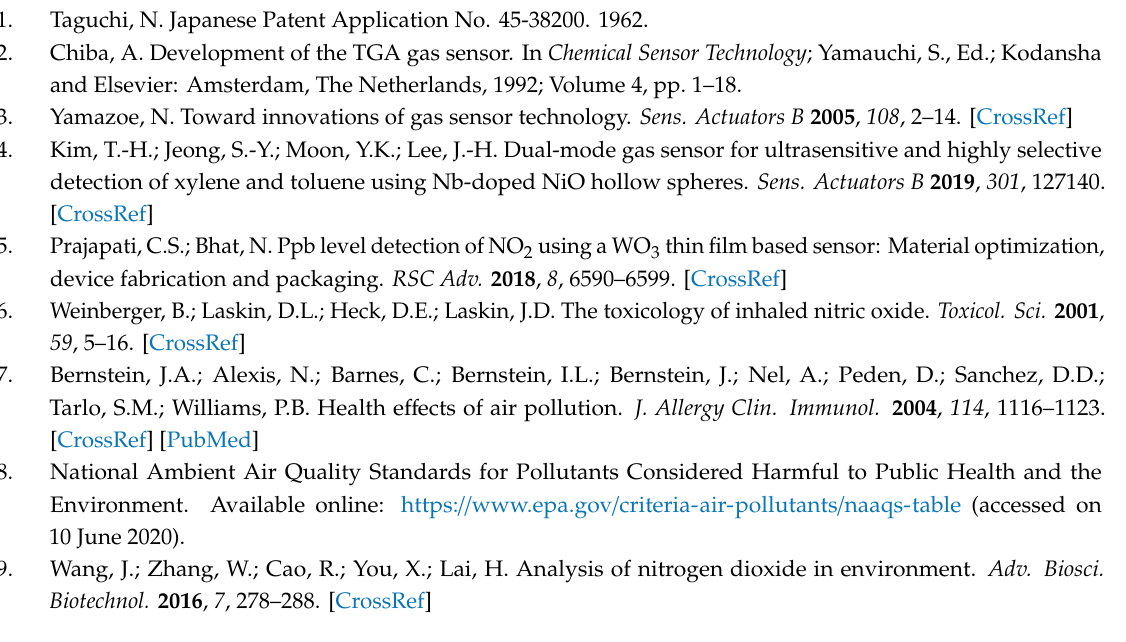
Figure S1: Schematic drawing of (a) sensor element and (b) gas-sensing measurement system., Figure S2: Particle size distribution of precursor mists containing In 2 (NO 3 ) 3 and PMMA microspheres prepared by the ultrasonic vibrator, Figure S3: Variations in 70% recovery time ( t 70rec ) of the In 2 O 3 and Au / In 2 O 3 sensors in wet air (70%RH at 25 ◦ C) with operating temperature, Figure S4: Schematic illustrations of the Gibbs energy diagram for the chemical adsorption of NO 2 over (a) In 2 O 3 surface and (b) Au / In 2 O 3 surface, Figure S5: Schematic views of gas adsorption properties of In 2 O 3 and Au / In 2 O 3 surfaces in wet air and NO balanced with wet air at 100 ◦